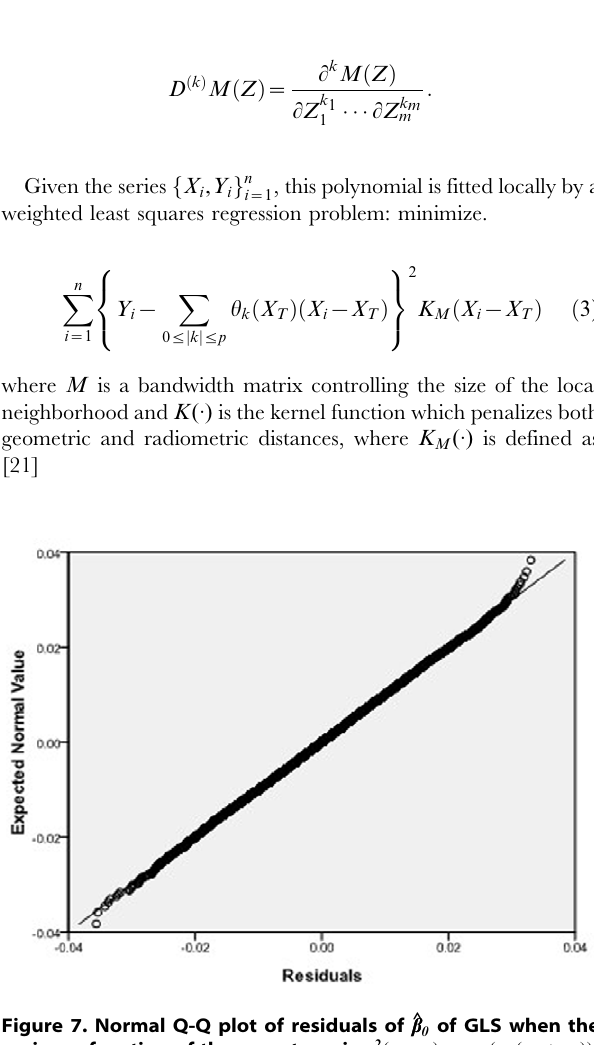
Figure 6. Histogram and asymptotic distribution for ^ bb 2 of GLS when the variance function of the error term is s 2 ( x 1 , x 2 ) ~ exp ( { ( x 1 z x 2 )) .